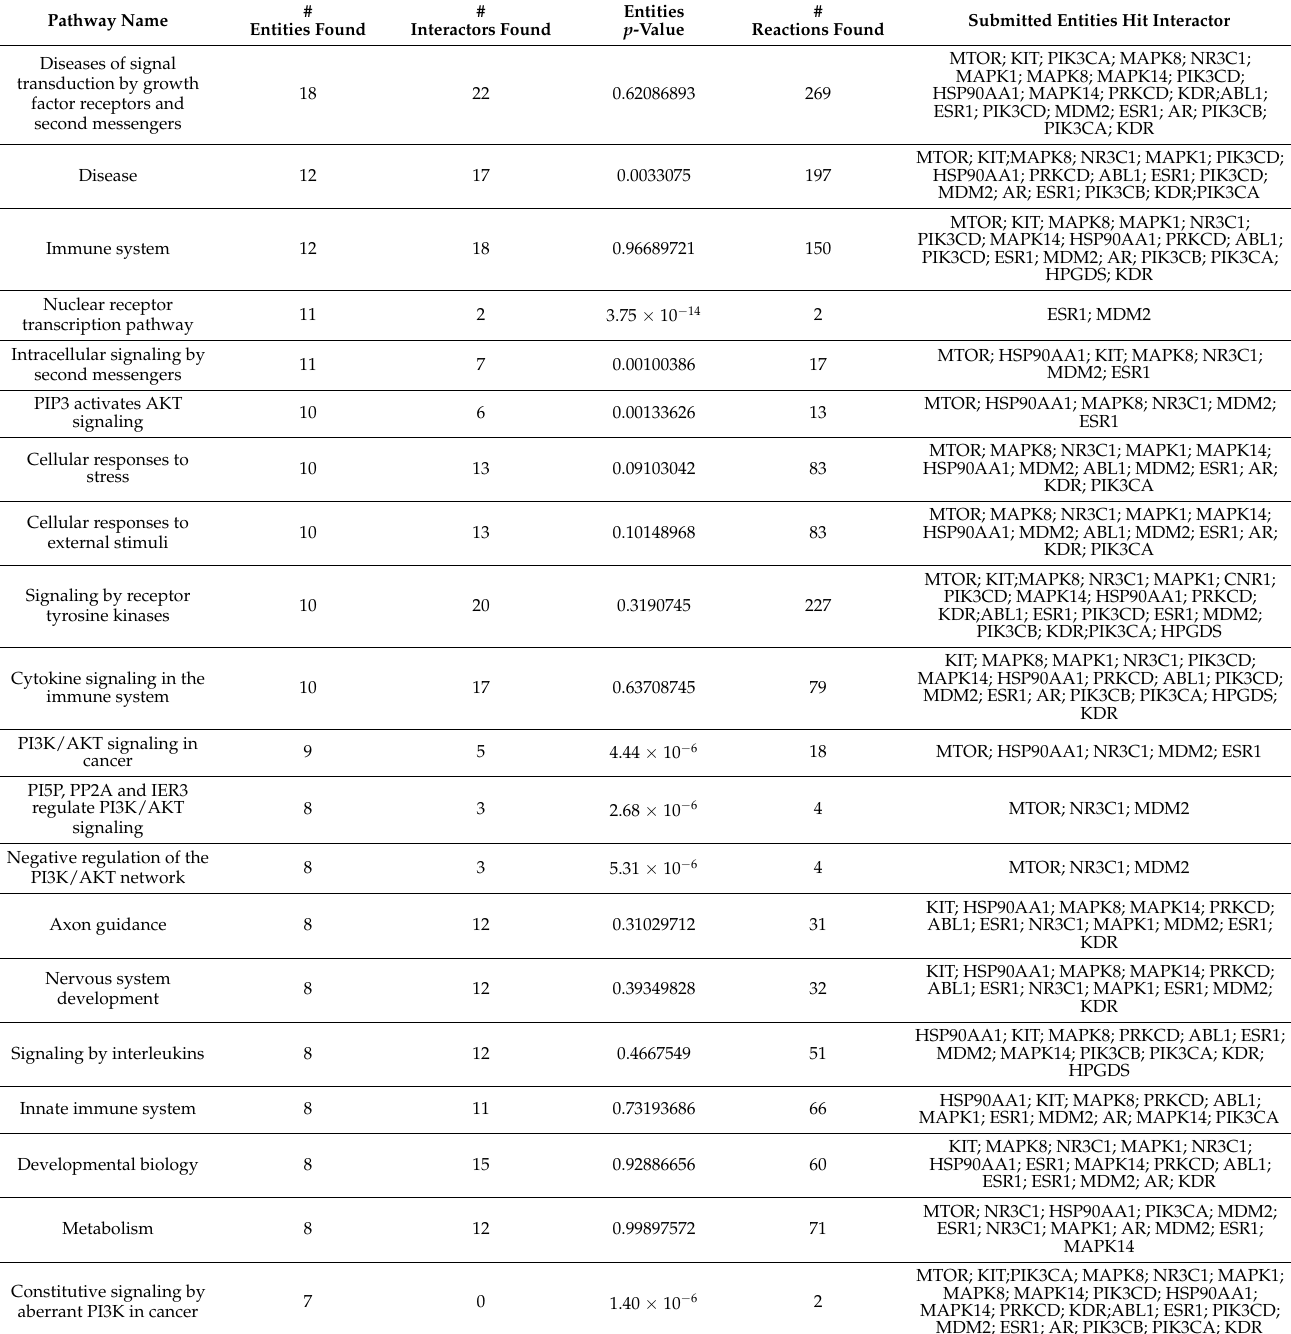
Table 3. Top 20 pathways for ST1 targets resulting from the pathway enrichment analysis